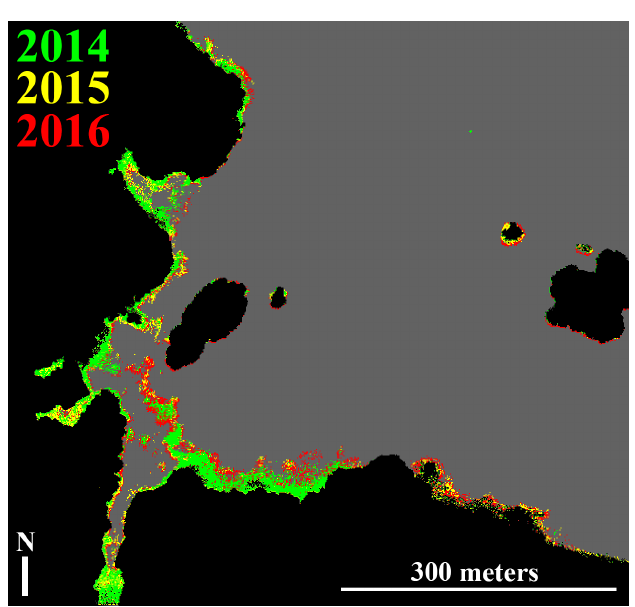
Figure 10 . Extent of Phragmites australis derived from airborne lidar acquisitions in 2014 (green), 2015 (yellow), and 2016 (red). The small, isolated patch in the North East (green) is an artificial platform for nutrient enrichment experiments, and was excluded from analyses.